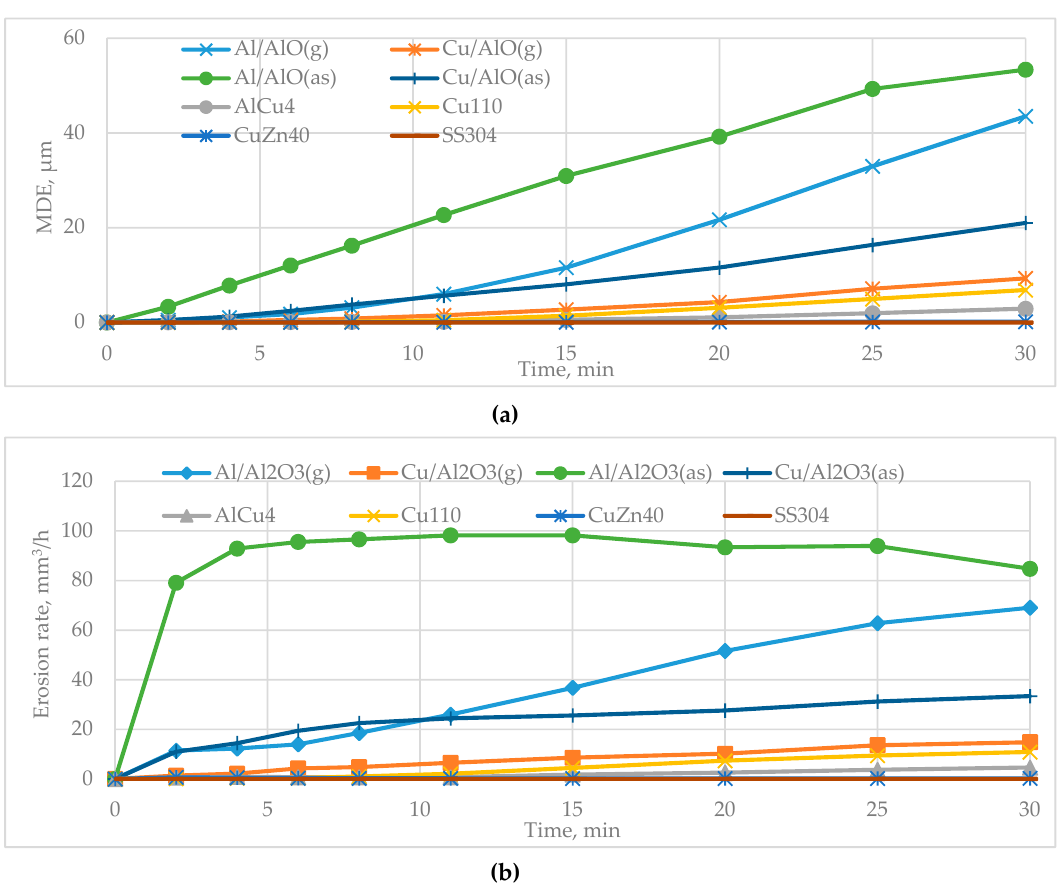
Figure 7. Cumulative erosion versus time curves: ( a ) Mean depth of erosion, MDE; ( b ) erosion rate. Composites with different surface finish: Ground (g) and as-sprayed (as).